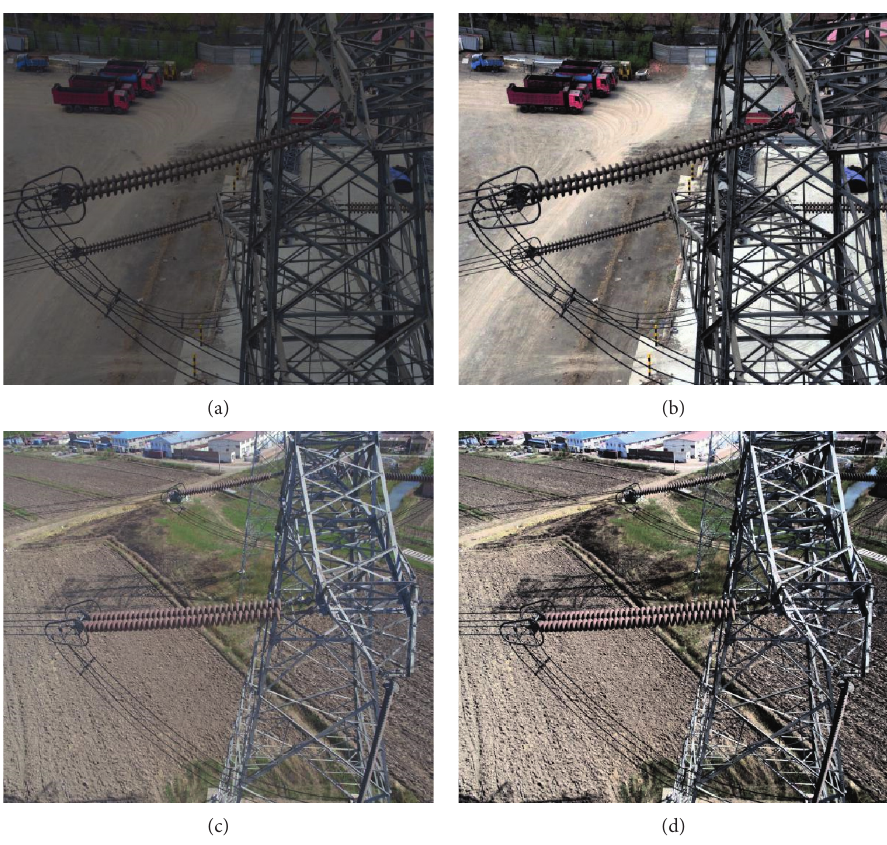
Figure 2: Images before and after histogram equalization.